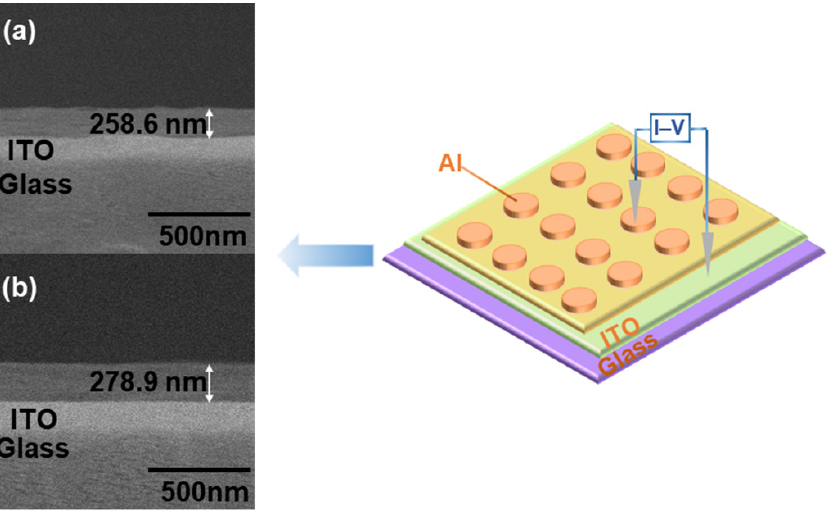
Figure 4. Cross-sectional SEM images of the devices based on different active layers: ( a ) pure PF-BBO and ( b ) PF-BBO/Au NPs.